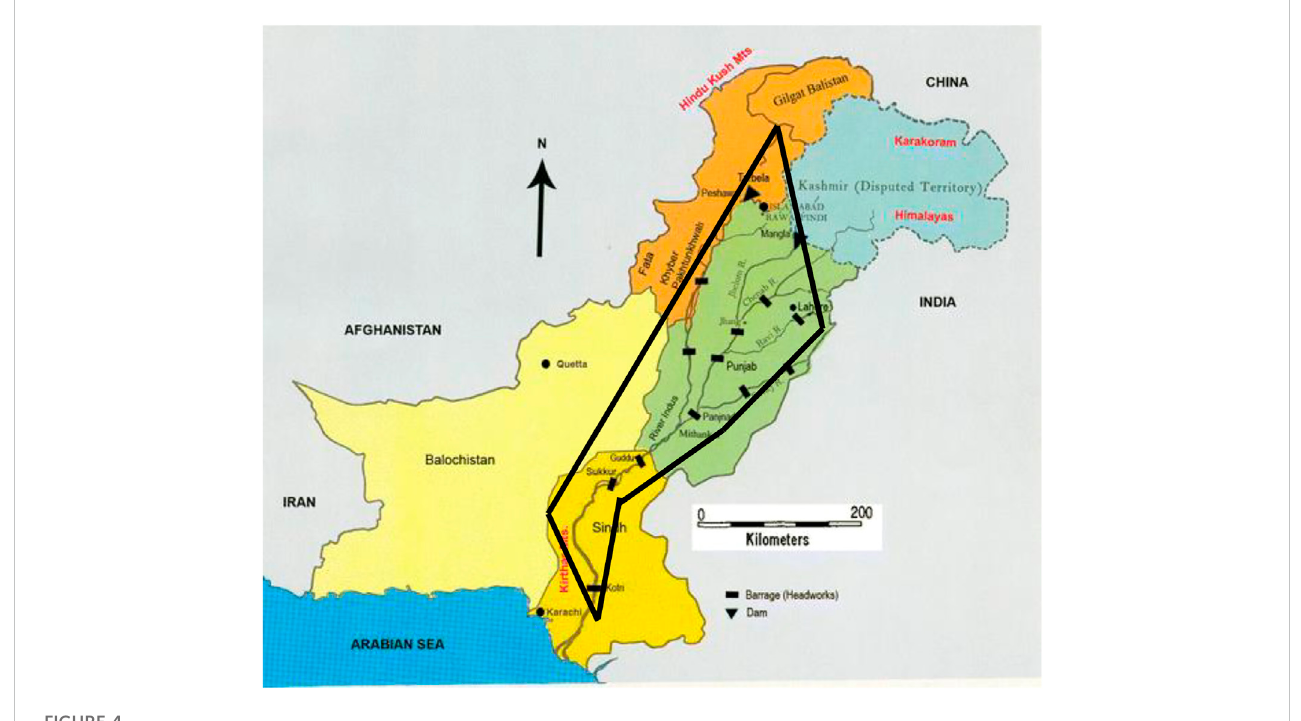
FIGURE 4 Field visits to the indus basin area.